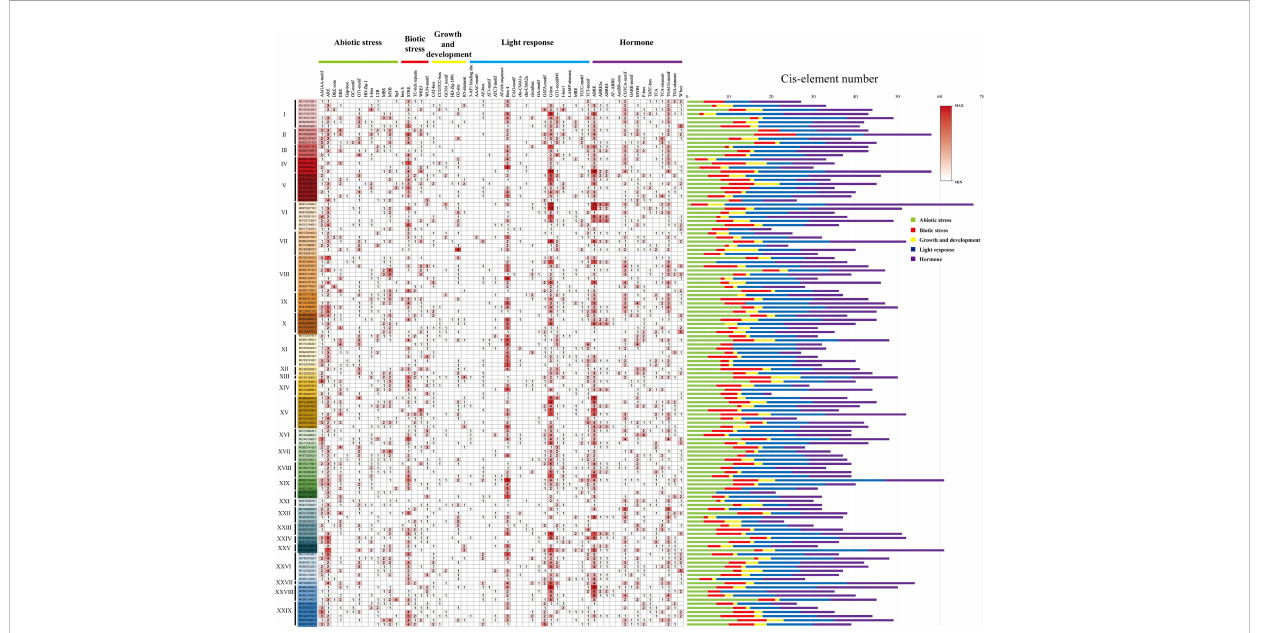
FIGURE 5 Analysis of the cis -acting elements in the promoter region of the R2R3-MsMYB genes. Top: different color bars indicate the classi fi cation of different cis -elements. I – XXIX show the subfamily of R2R3-MsMYB